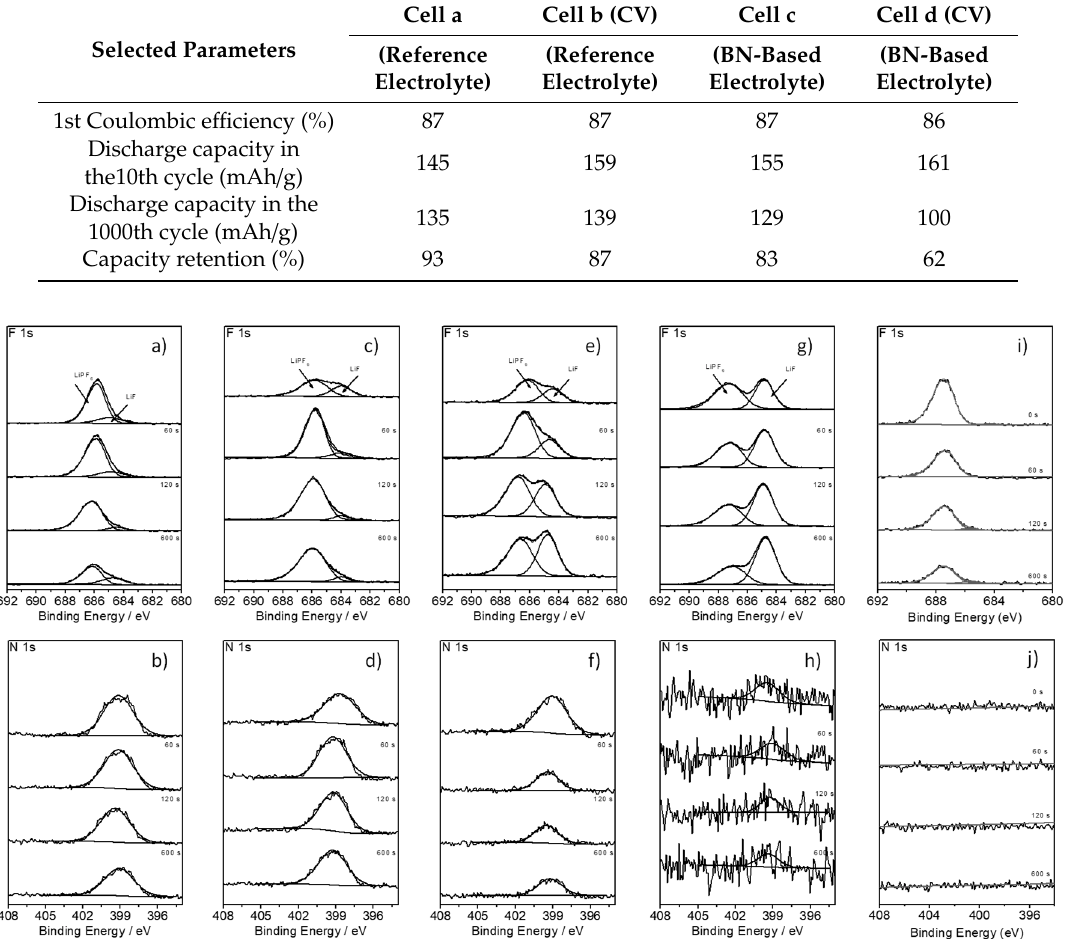
Table 3. 1st Coulombic e ffi ciency, discharge capacity as well as capacity retention between the 10th and 1000th cycle for the reference electrolyte (cells a / b) and the nitrile-based electrolyte formulation (cells c / d) containing cells.